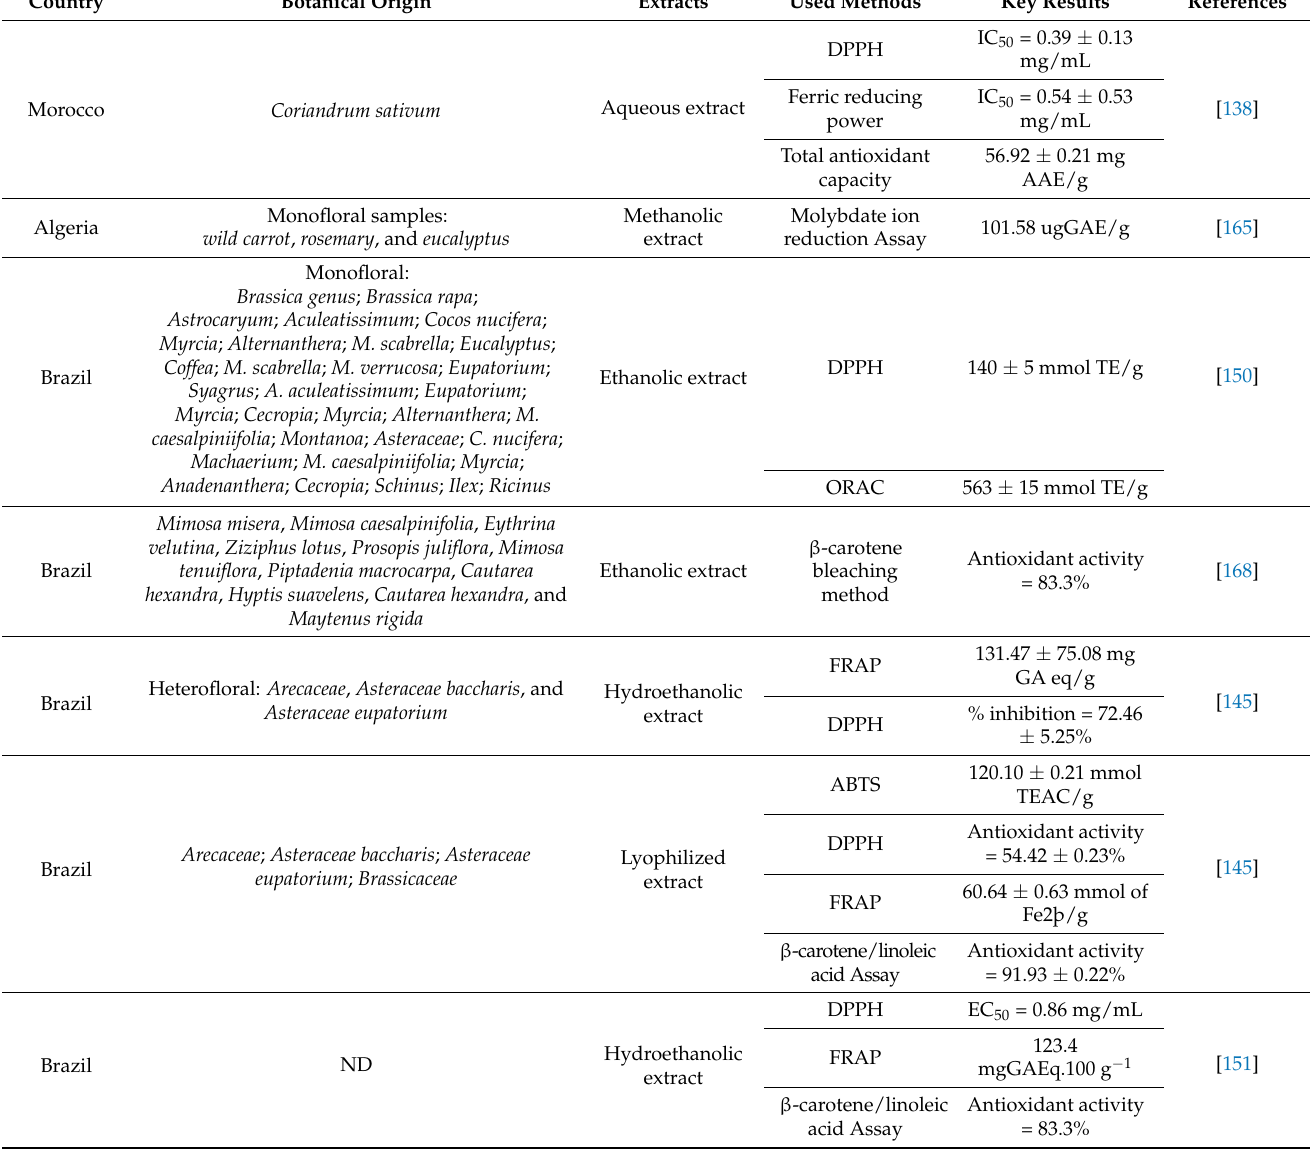
Table 3. Summary of the different studies of the antioxidant activity of bee